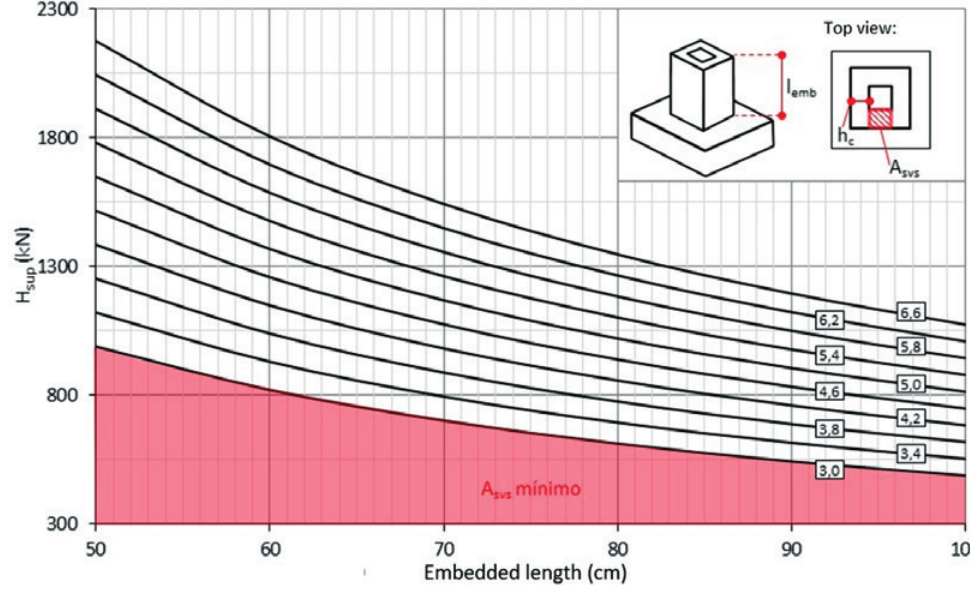
Abacus for calculating the secondary vertical reinforcement (cm 2 ) for a C25 concrete and a CA-50